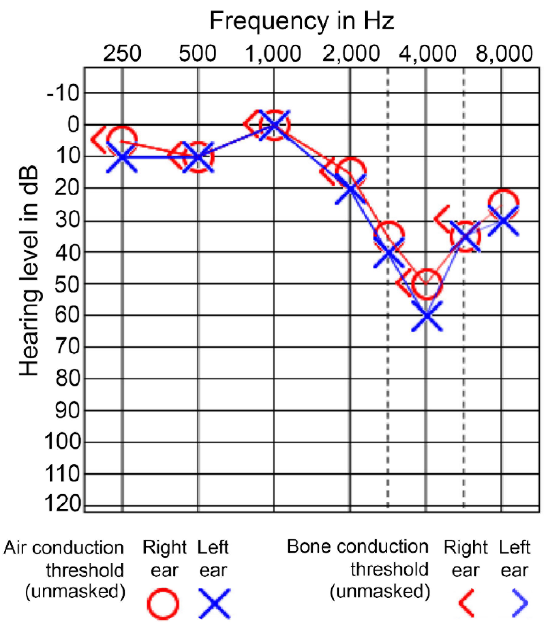
Figure 4. Characteristic audiogram of an individual with NIHL. The signature pattern of hearing loss is focused on 3–4 kHz range. Made with Interactive Audiogram Plotter (https://audprof.com/ aud_tools/audiogram/; accessed on 1 February